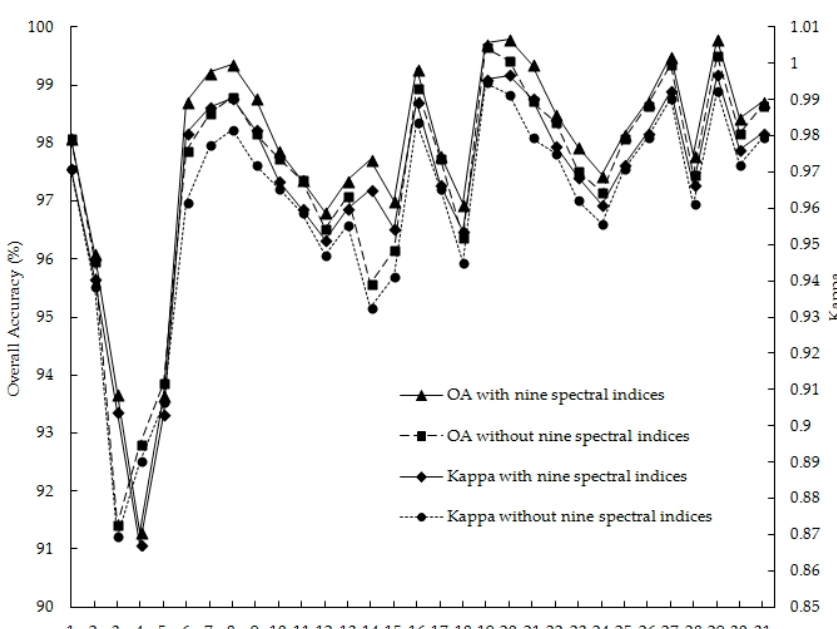
Figure 14. Overall classification accuracies and Kappa coefficients for land cover classification from the thirty-one pairs with and without nine spectral indices. (1–5 stands for singe season March (1), May (2), July (3), October (4), December (5), 6–15 identifies two-seasons combined March + May